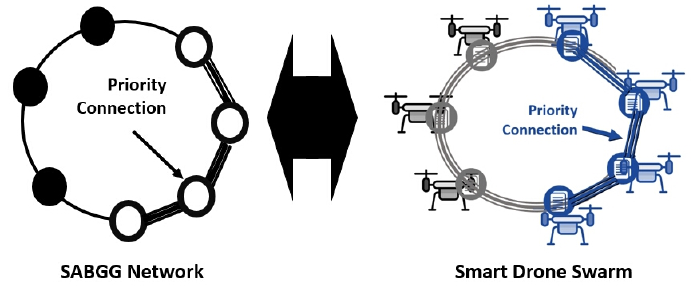
Figure 3. Adapting SABGG for the drone swarm network